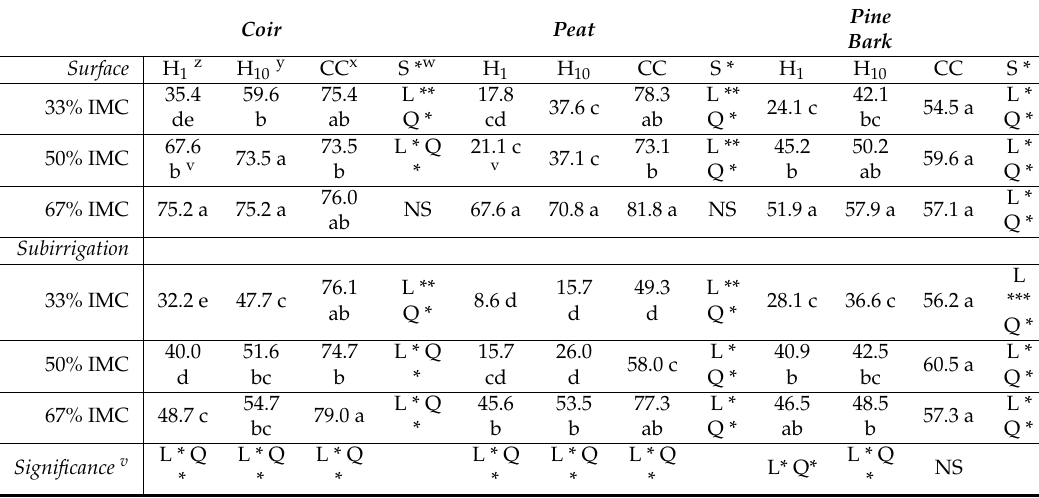
= the amount (by volume) of water that is absorbed by the substrate after one irrigation event. y H z H 1 amount (by volume) of water that is absorbed by the substrate after the final hydration event. x CC =